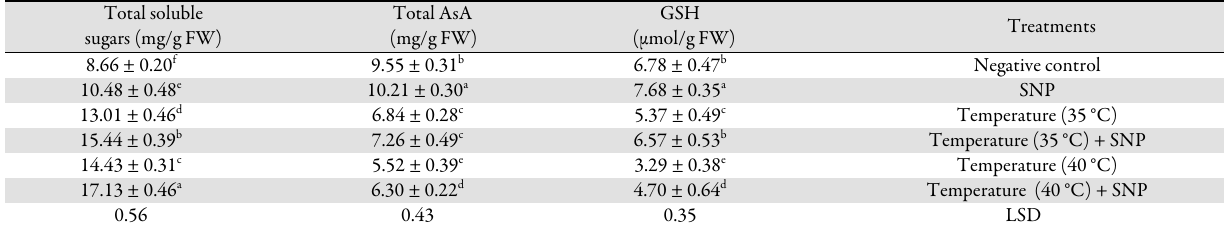
Means in the same column with the same letter were not significantly at P< 0.05. Table 3. Effects of heat stress and SNP treatments on the activities of SOD, APX and GR in wheat callus GR activity